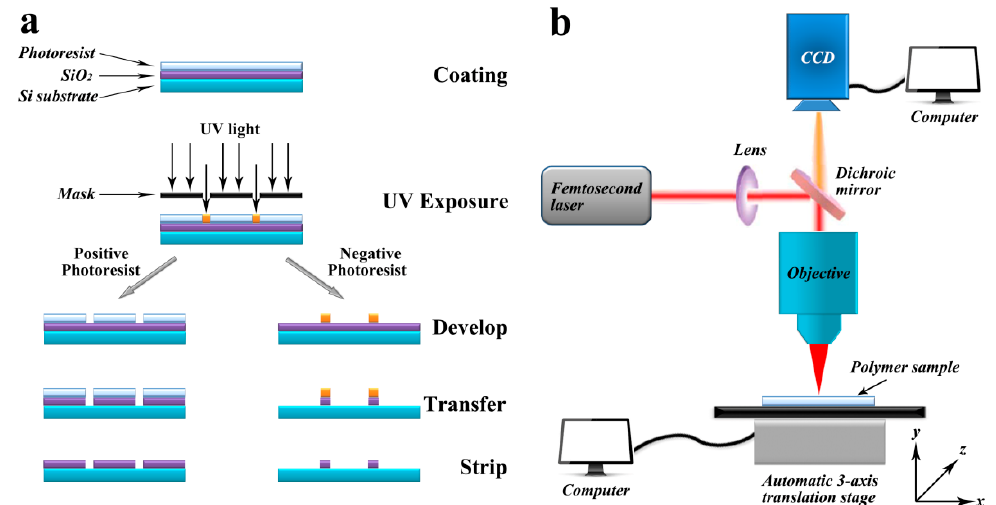
Figure 8. ( a ) Schematic diagram of photolithography process using positive or negative photoresist. ( b ) Schematic diagram of a three-dimensional laser ablation machine.